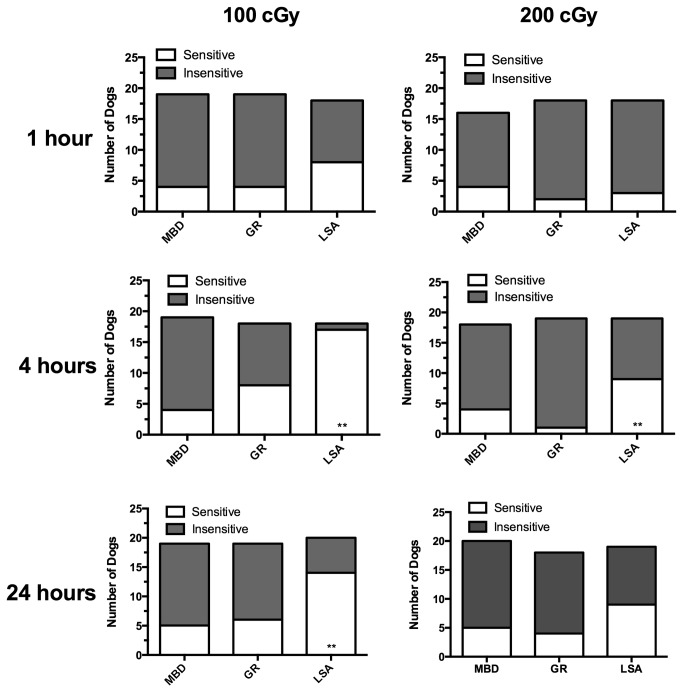
Proportions of dogs “sensitive” and “insensitive” to induction of chromosomal damage following ionizing radiation exposure.Dogs were defined as “sensitive” if the number of gross chromatid breaks exceeded the 75th percentile of the reference (normal mixed-breed dog) population. The proportion of dogs demonstrating chromosomal sensitivity was significantly higher in golden retrievers with lymphoma (LSA) than in clinically normal golden retrievers (GR) at the 4-hour time point for both radiation doses and at the 24 hour time point for 1.0 cGy. A similar but insignificant trend was observed for most of the other doses and times. These results suggest compromised DNA repair capacity in the lymphoma dogs. ** = p < 0.05 vs. normal GR.